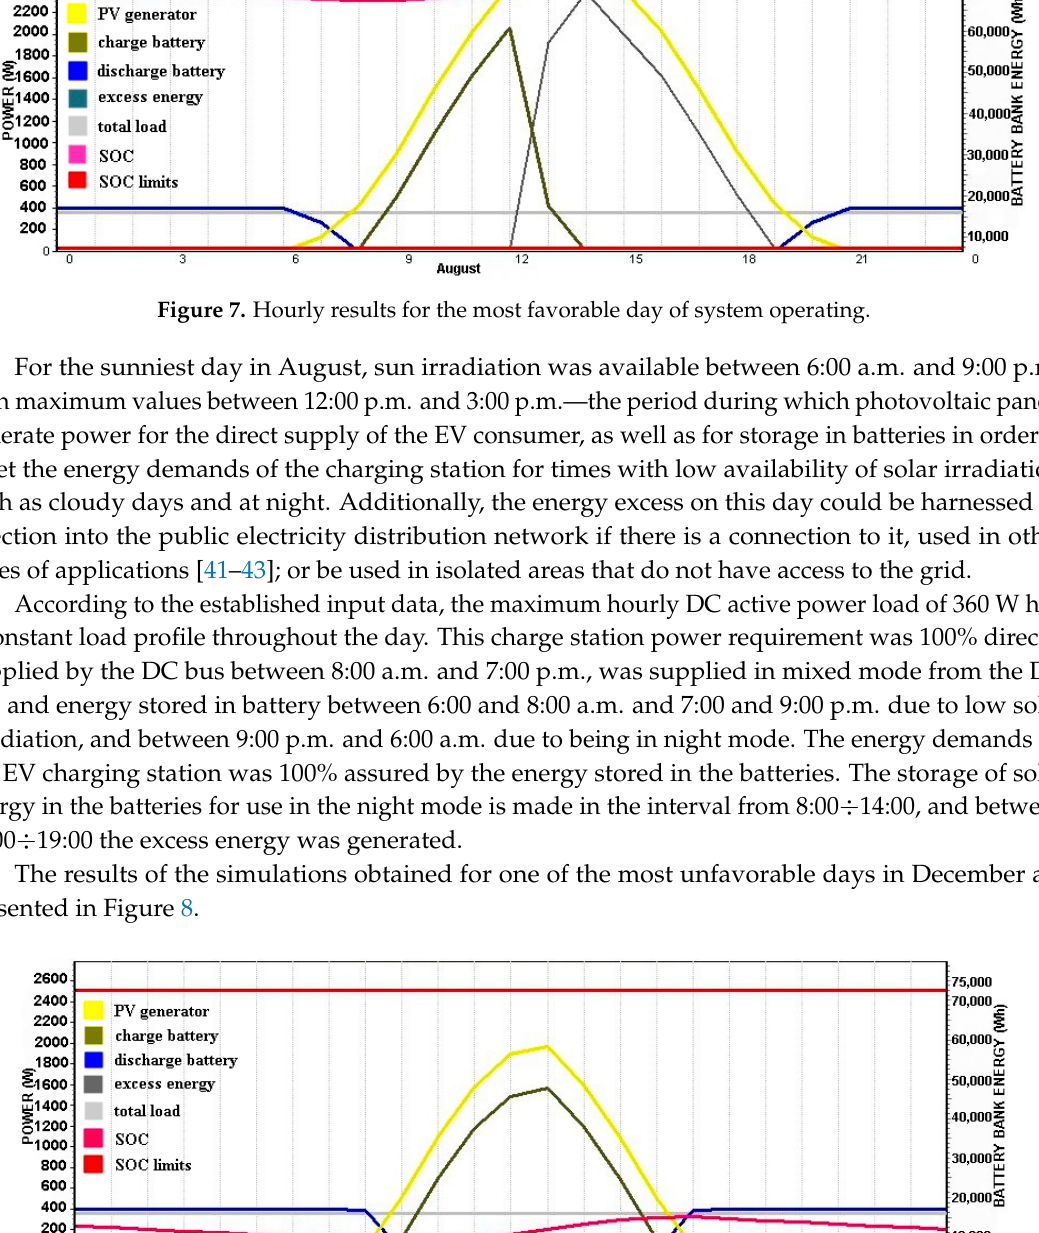
Figure 6. Monthly and annual average power.